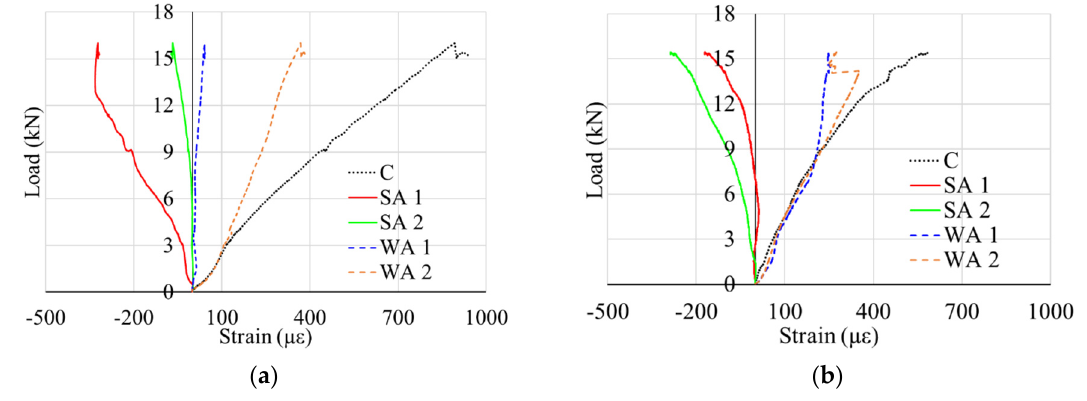
Figure 5. Load-strain curves ( a ) D1 sample, ( b ) D2 sample.